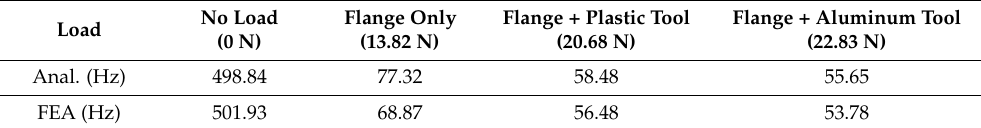
Table 3. Analytical model and FEA results of first natural frequency under different loads.